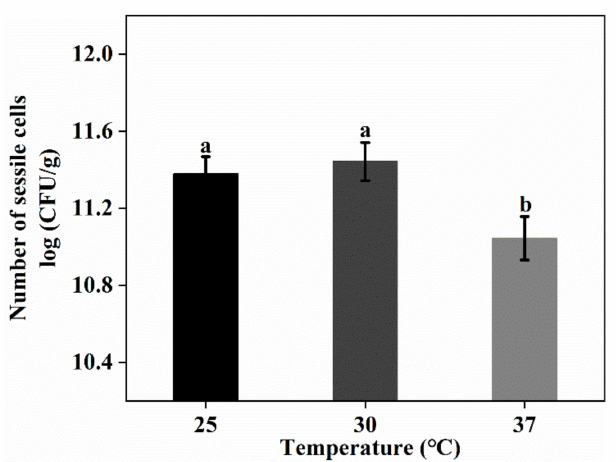
Figure 6. The influence of different culture temperatures on the number of sessile cells. Significant differences ( p < 0.05) are indicated by different letters (a and